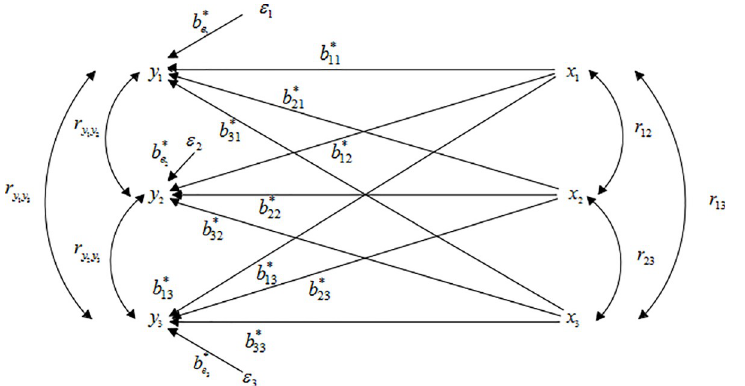
Fig 2. Multiple-to-multiple path analysis